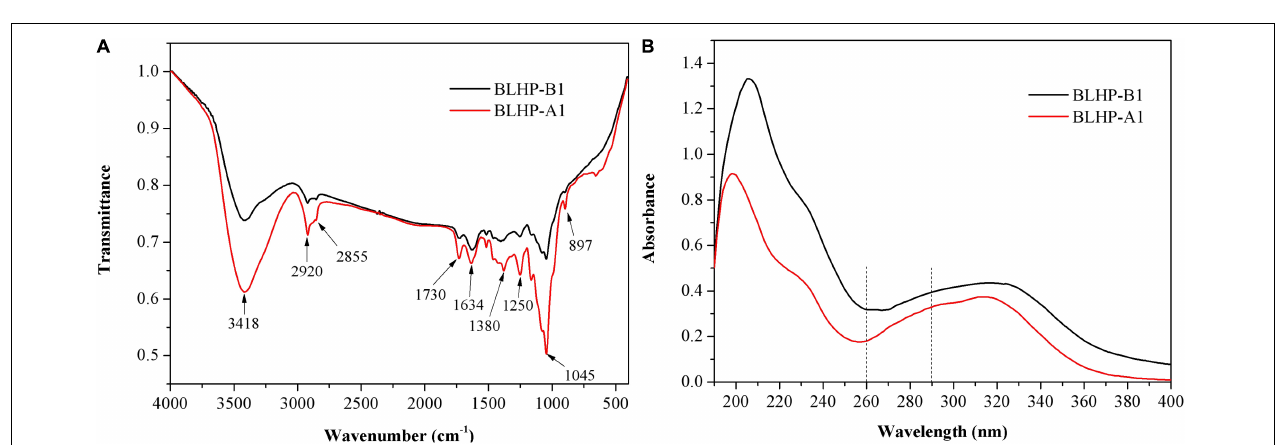
FIGURE 4 | FT-IR spectra analysis (A) and UV full scanning (B) of BLHP-A1 and BLHP-B1 fractions.